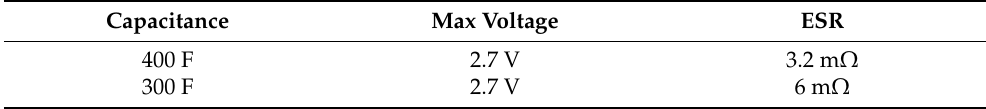
Table 2. EDLCs datasheet